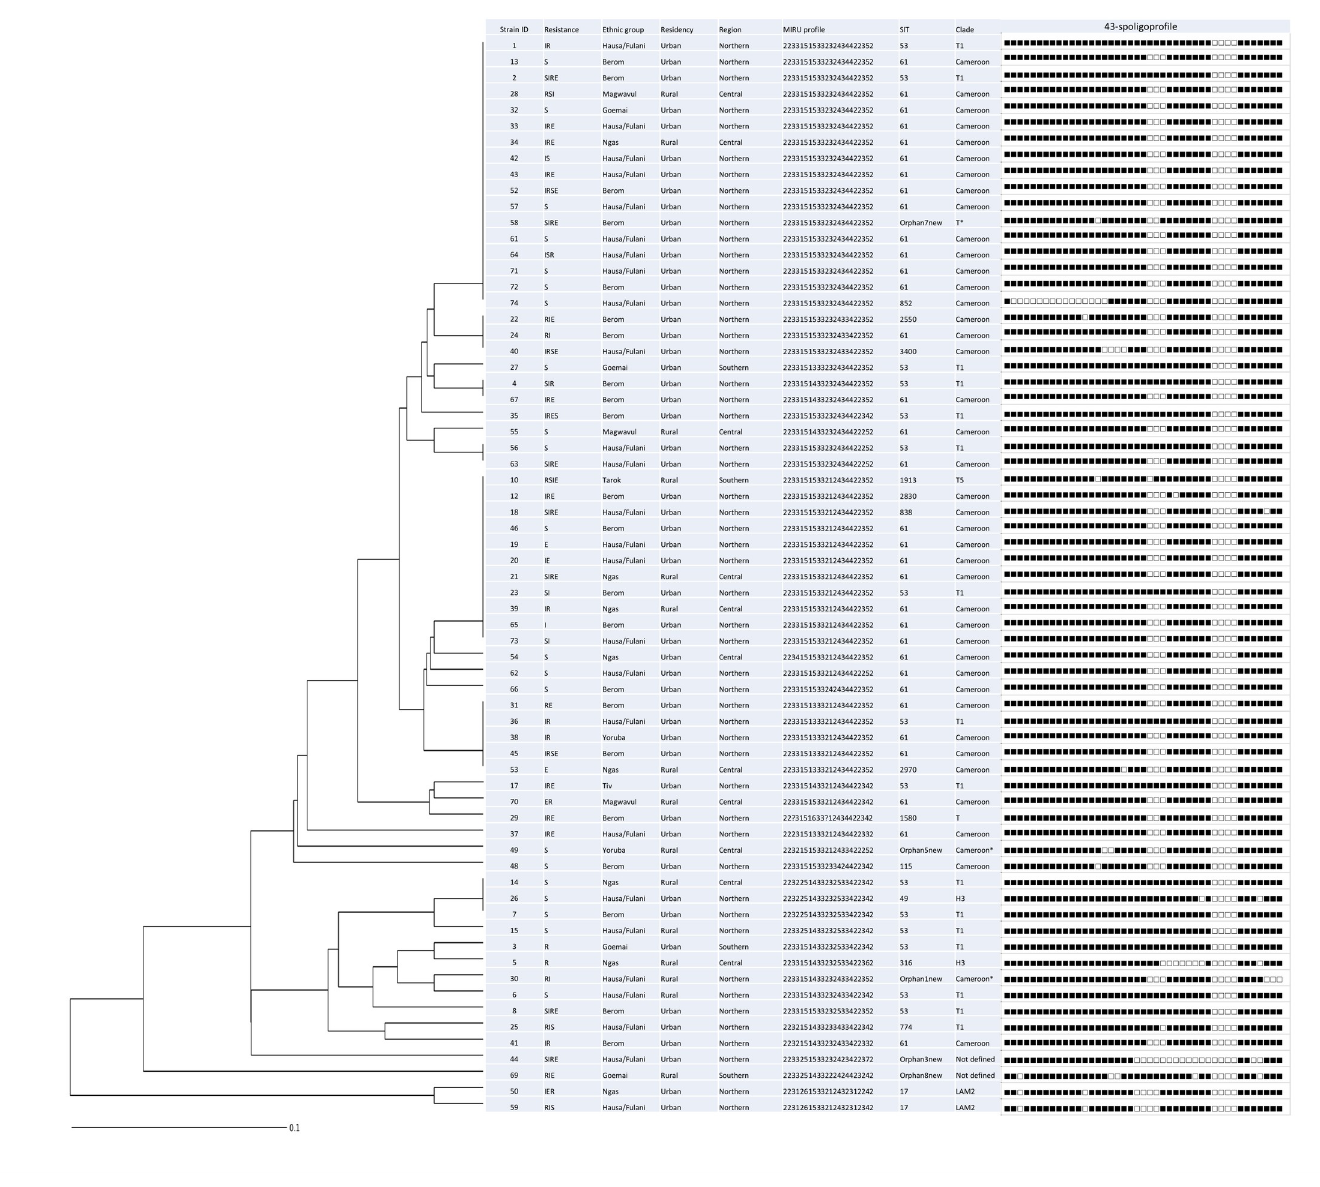
Fig 2. Dendrogram based on the 22 VNTR loci for 67 M . tuberculosis isolates from the Plateau State, Nigeria. Abbreviations: I–isoniazid; R–rifampicin; E– ethambutol; S–streptomycin; SIT—Shared International Type; 22 MIRU loci order: MIRU 2-4-10-16-20-23-24-26-27-31-39-40, Mt-04, ETR-C, Mt-21, ETR-A, Mt-29, Mt- 30, ETR-B, Mt-34, QUB-26, QUB-4156c.